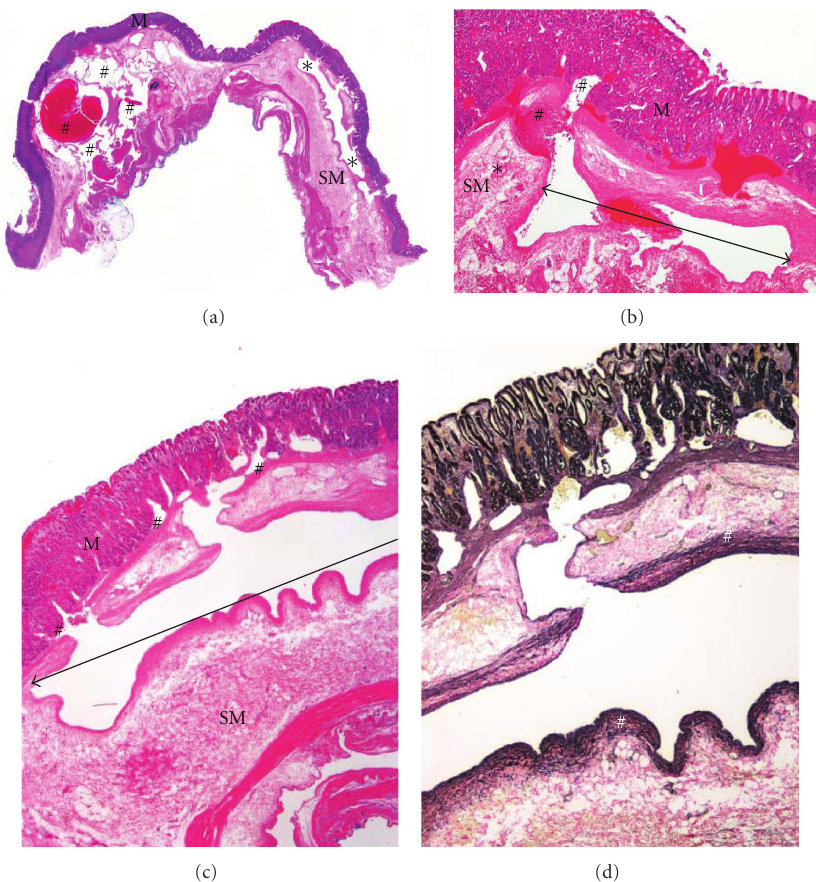
Figure 2: Histopathological findings. (a) Whole-mount scan of hematoxylin and eosin stained slide showing the exulceratio simplex ( ∗ ) in the submucosa (SM) (below the mucosa (M)) as described by Dieulafoy. Additionally, (#) shows the presence of a complex rich anastomosis of varying sized vessels in the submucosa with an intraluminal haemorrhagic thrombus (cirsoid aneurysm of gastric vessels). (b) Low magnification (objective lens × 2) of hematoxylin and eosin-stained slides shows the presence of blood within the large tortuous, caliber- persistent artery () in the submucosa (SM) with evidence of rupture and haemorrhage (#) through the overlying mucosa (M). A normal- sized submucosal arteriole ( ∗ ) is seen at the same level. (c) High magnification (objective lens × 10) of hematoxylin and eosin-stained slides shows the presence of the large caliber-persistent artery () in the submucosa (SM)—Dieulafoy’s lesion—with communications (#) into the overlying noninflamed mucosa (M). (d) High magnification (objective lens × 10) of elastin-stained slides shows the presence of elastin in the wall (#) of the exulceratio simplex confirming its arterial